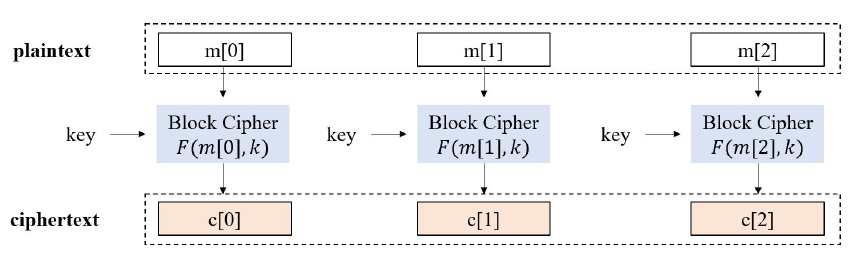
Figure 1. Block cipher in electronic codebook (ECB) mode.